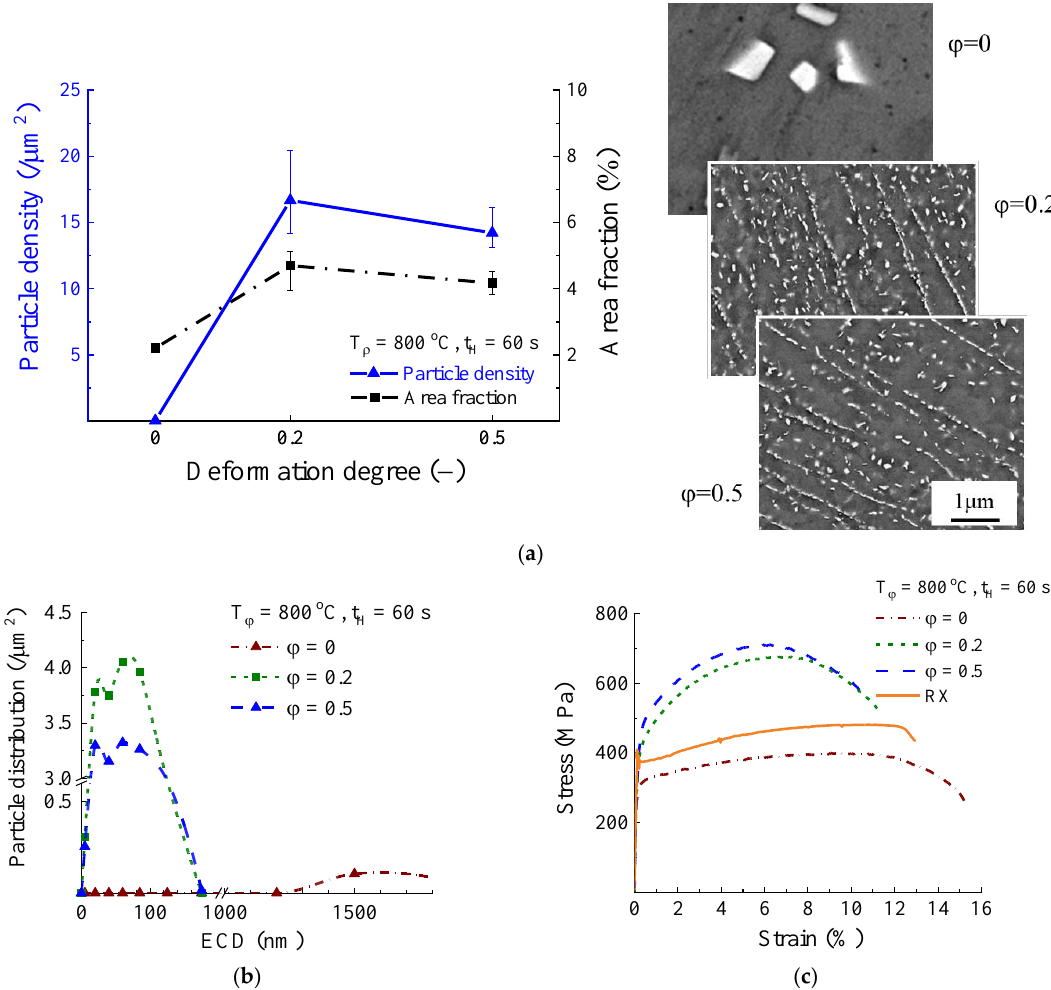
Figure 8. Influence of TMP deformation grade on ( a ) particle density and area fraction, ( b ) particle size distribution, and ( c ) ambient-temperature tensile properties (t H = 60 s, T = 800 °C, φ = 0, 0.2, 0.5).